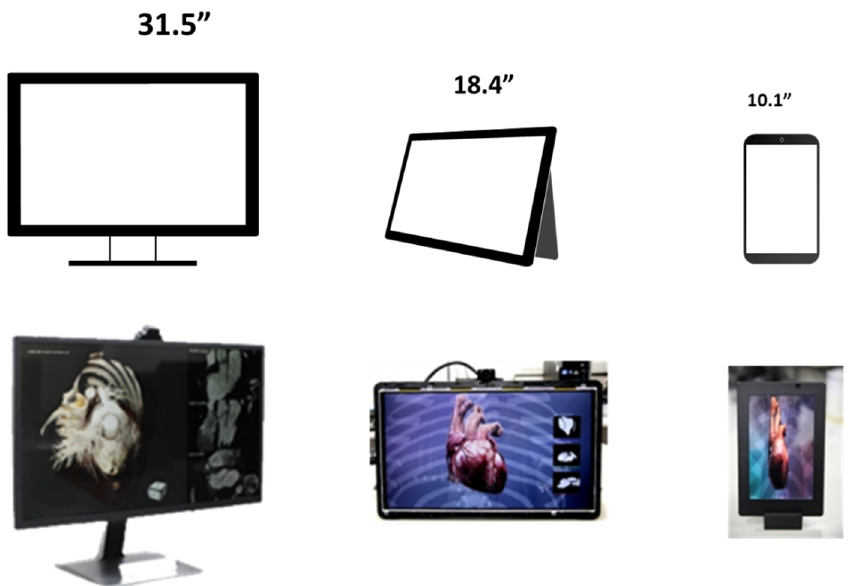
Figure 9. Proposed implemented prototypes of an autostereoscopic 3D display system for 3D medical images (( left ) 31.5”, ( middle ) 18.4”, ( right ) 10.1”). In the 31.5” monitory prototype ( left ), the light field 3D subpixel rendering is processed with a GPU and the eye tracking algorithm is processed with only CPU computations in Windows PC. In the 18.4” ( middle ) and the 10.1” ( right ) tablet display prototypes, the light field 3D subpixel rendering and eye tracking are processed in the FPGA board.